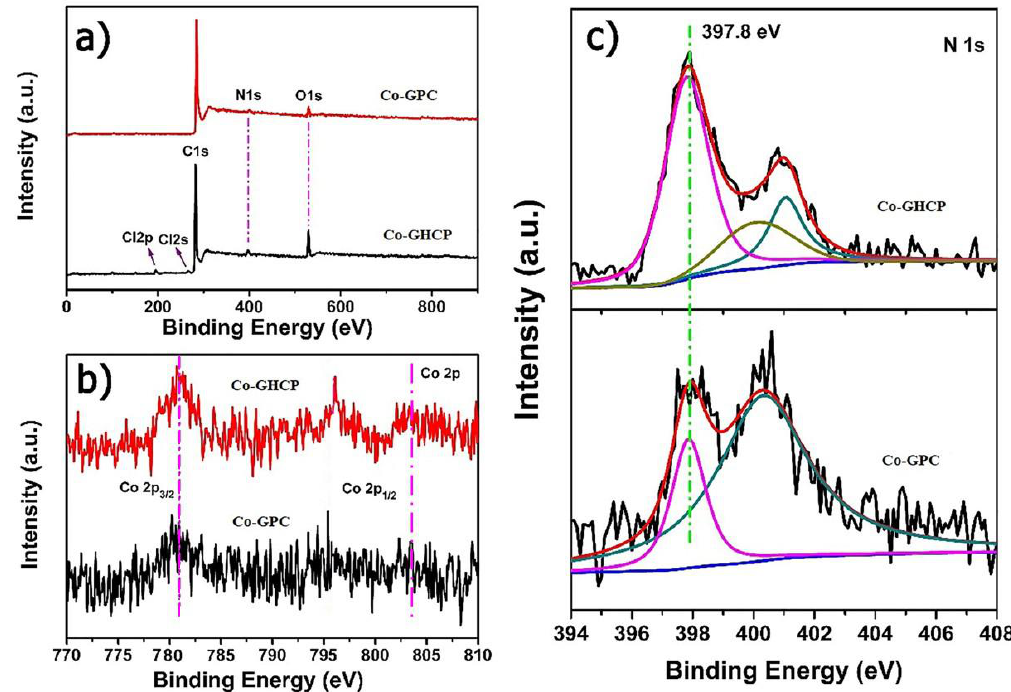
Figure 4. X-ray photoelectron spectroscopy of Co-GHCP and Co-GPC ( a ) survey, ( b ) Co 2p, ( c ) N 1s, respectively.